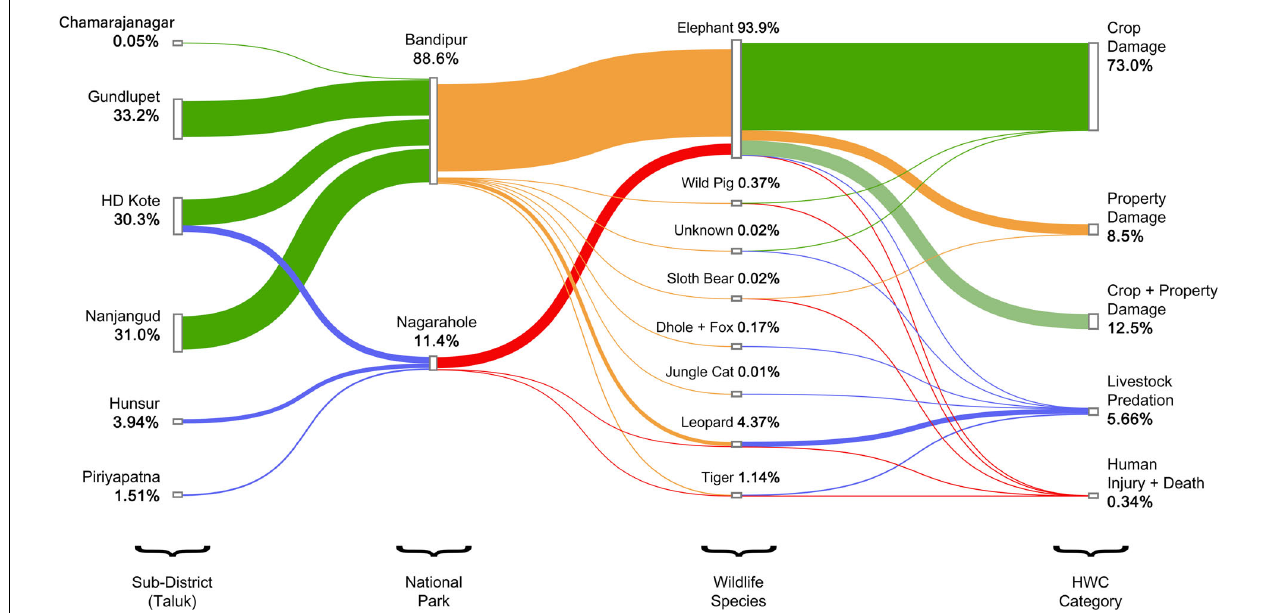
FIGURE 2 | Flow diagram depicting human-wildlife conflict (HWC) incidents as a percentage of the total cases ( n = 13,808) registered by Wild Seve across administrative domains and HWC categories. The figure shows the percentage fraction across a domain at each node, with the width of links indicating the flow between administrative divisions (sub-districts), forest divisions (national parks and forest ranges), wildlife species, and HWC categories.